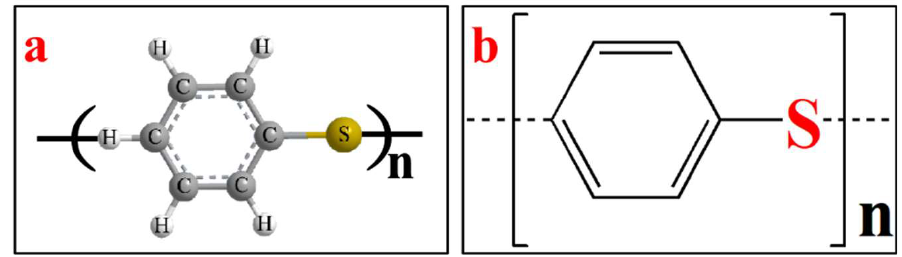
Figure 1. ( a ) Ball and stick model of PPS structure; ( b ) the chemical structure of PPS.